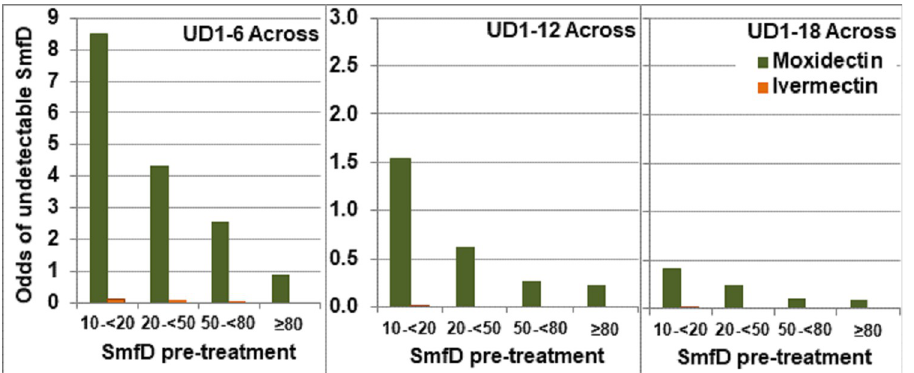
Fig 6. Odds for undetectable SmfD from 1 to 6, 12 or 18 months by IoI across study areas. SmfD skin microfilariae density, UD1-6, UD 1–12, UD 1–18 undetectable levels of SmfD at month 1 and 6, at month 1, 6 and 12, and at month 1, 6, 12 and 18, respectively (for number with follow up data at each relevant time point, see Table S11 in S 1 File ).